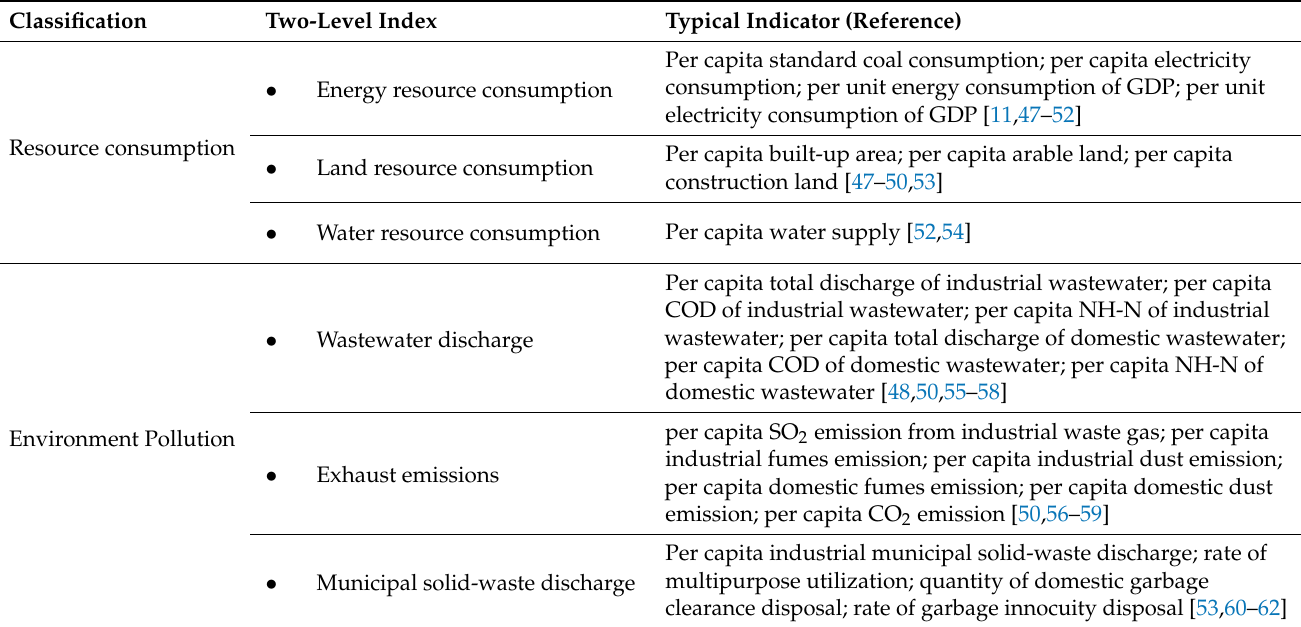
Table 1. Candidate indicators for evaluating ecological